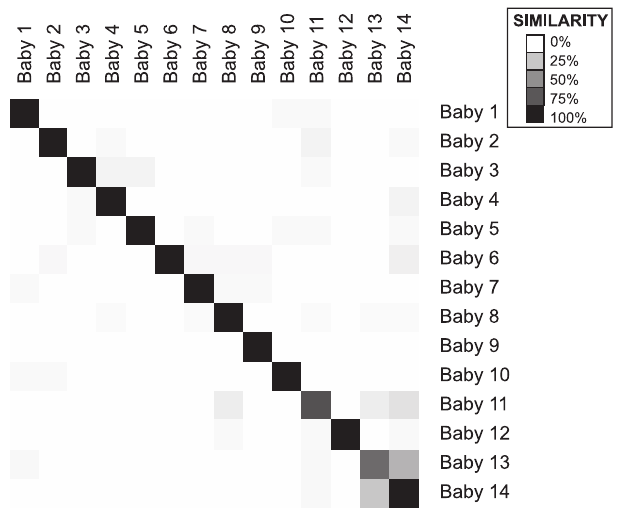
Figure 5. Similarity of Microbiota between Babies For each pair of samples, we calculated the nearest-neighbor samples according to Pearson correlation of the level 4 relative abundance profiles. For each baby, we then computed what percent of nearest- neighbor samples came from each baby. The shade of grey indicates the percent of samples from baby Y (column) that were nearest neighbors of the samples from baby X (row) such that rows add to